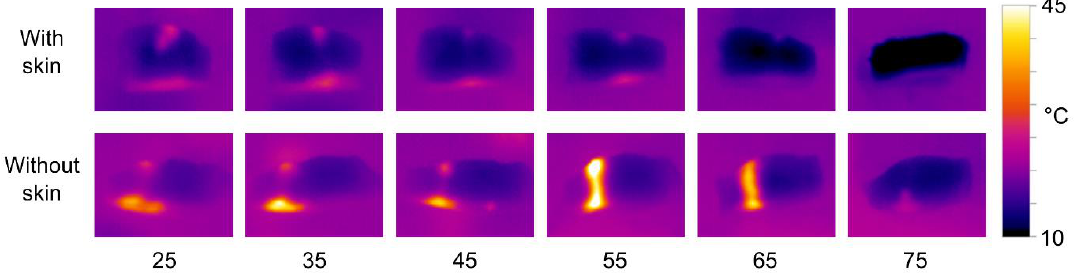
Figure 8. Thermal images of salmon samples treated with the 680 kHz transducer for 20 s. The transducer-sample distance is listed below each set of images.